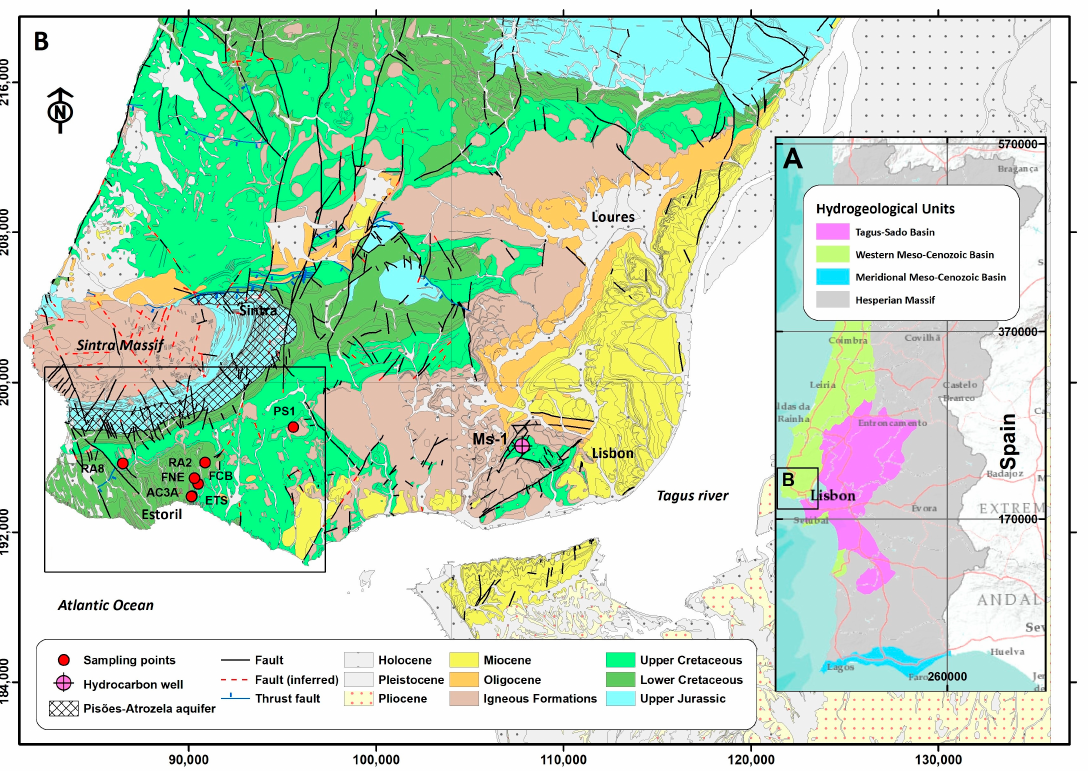
Figure 1. ( A ) Main hydrogeological units of mainland Portugal, adapted from [39]. ( B ) Simplified geological map of the Lisbon-Cascais-Loures-Sintra region, adapted from [40], showing the sampling point locations and the Monsanto hydrocarbon well (Ms-1).